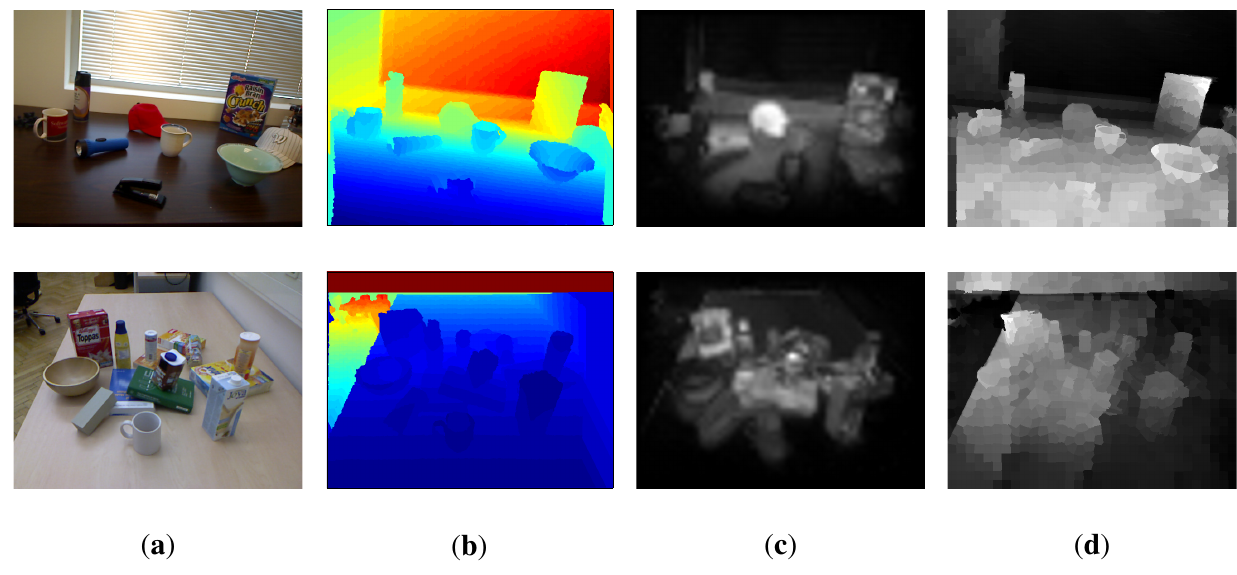
Figure 2. Given a pair of an RGB image ( a ) and a depth image ( b ), the proposed algorithm strength saliency (SS) outputs the color-based saliency map ( c ), while the employed method [15] outputs the depth-based saliency map ( d ). The two types of saliency maps supplement each other to find sufficient salient